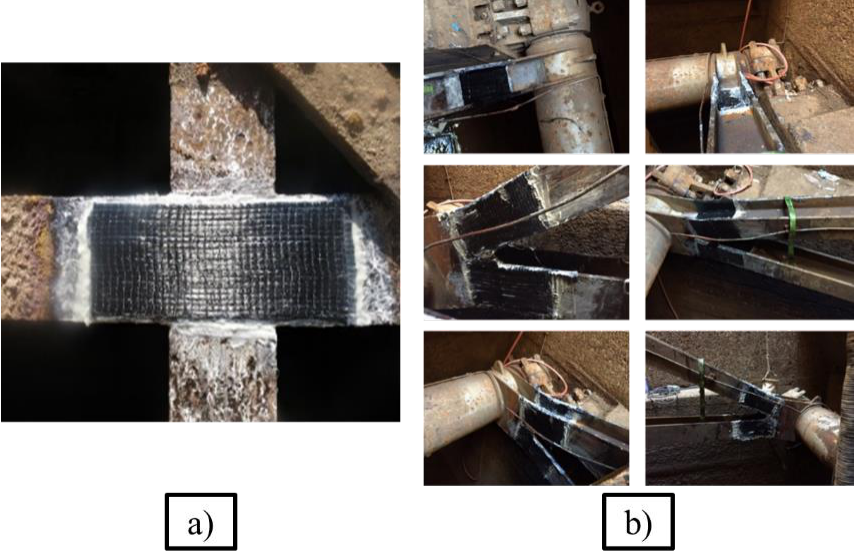
Figure 2. Implemented carbon fiber reinforced polymer (CFRP) repairs. ( a ) Miter gate flange. ( b ) Tainter valve strut arm.